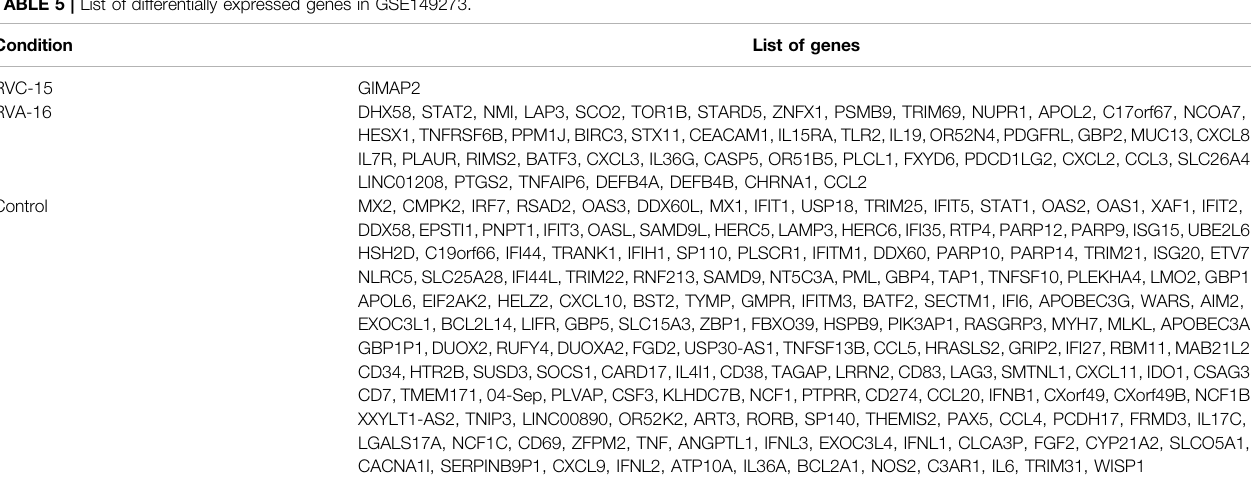
TABLE 5 | List of differentially expressed genes in GSE149273.